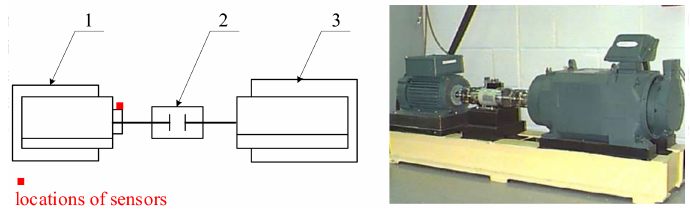
Figure 15. Rolling bearing fault simulator. 1, 3-Hp motor, 2-Torque transducer and encoder Table 2. Rolling element bearing